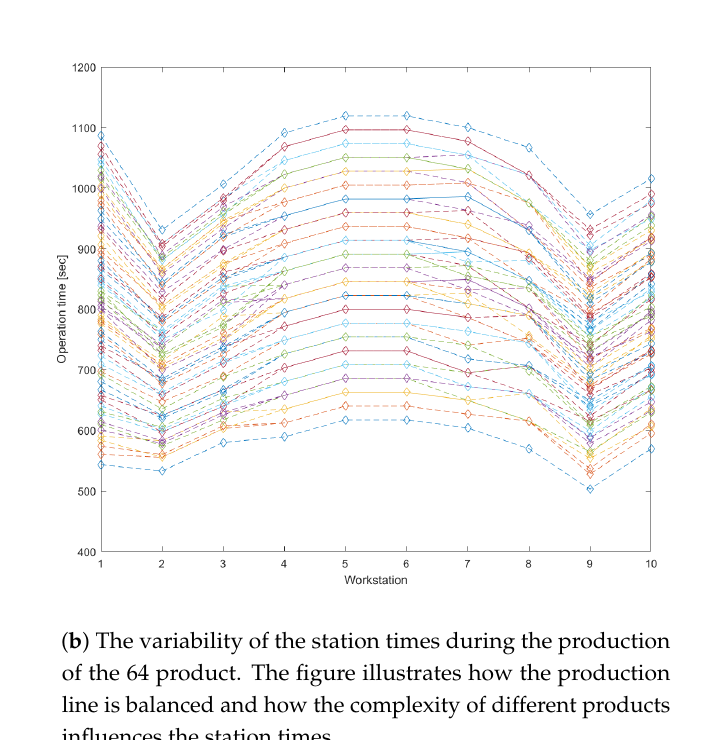
Figure 10. The workloads (number of activities, built-in components and total activity times) can be easily calculated based on the proposed model. The OEE of the production line can be monitored on-line based on the recursively estimated activity